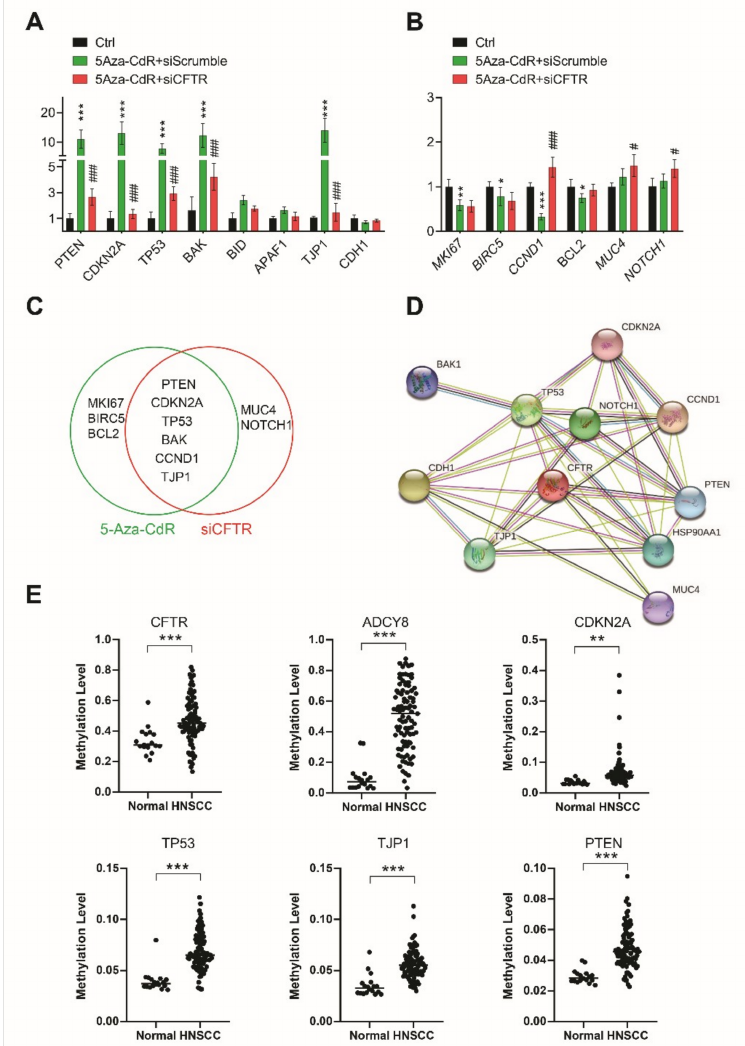
Figure 5. The interaction of CFTR with cancer-related genes; Analysis of DNA methylation profile data from GEO, Gene Expression Omnibus. ( A - C ) Real-time PCR of mRNA expression of cancer-related genes with or without 5-Aza-CdR or CFTR siRNA in A253 cells. ( A ) Tumor suppressor genes or anti-cancer genes, such as PTEN, CDKN2A, TJP1, TP53, BAK, BID, APAF1, and CDH1. ( B ) Tumor progression genes or oncogenes, such as MKI67, BIRC5, CCDN1, BCL2, MUC4, and NOTCH1. ( C ) Venn diagram representing the genes significantly changed by both 5-Aza-CdR and siCFTR (overlapping circles, PTEN, CDKN2A, TJP1, TP53, BAK, and CCDN1), 5-Aza-CdR only (green right circle, MKI67, BIRC5, and PCL2), or siCFTR only (red left circle, MUC4 and NOTCH1). All samples were run in triplicate. Data are expressed as mean ± SD (* or # , p < 0.05; ** or ## , p < 0.01; *** or ### , p < 0.001) using two-way ANOVA with Bonferroni’s test. * denotes significance compared with unstimulated control; # significance compared with 5-Aza-CdR-treated cells. ( D ) The protein-protein interaction (PPI) network of CFTR in the evidence view. Nodes, proteins; links, physical interaction between proteins. ( E ) Comparison of DNA methylation levels of six genes in 18 normal and 91 HNC